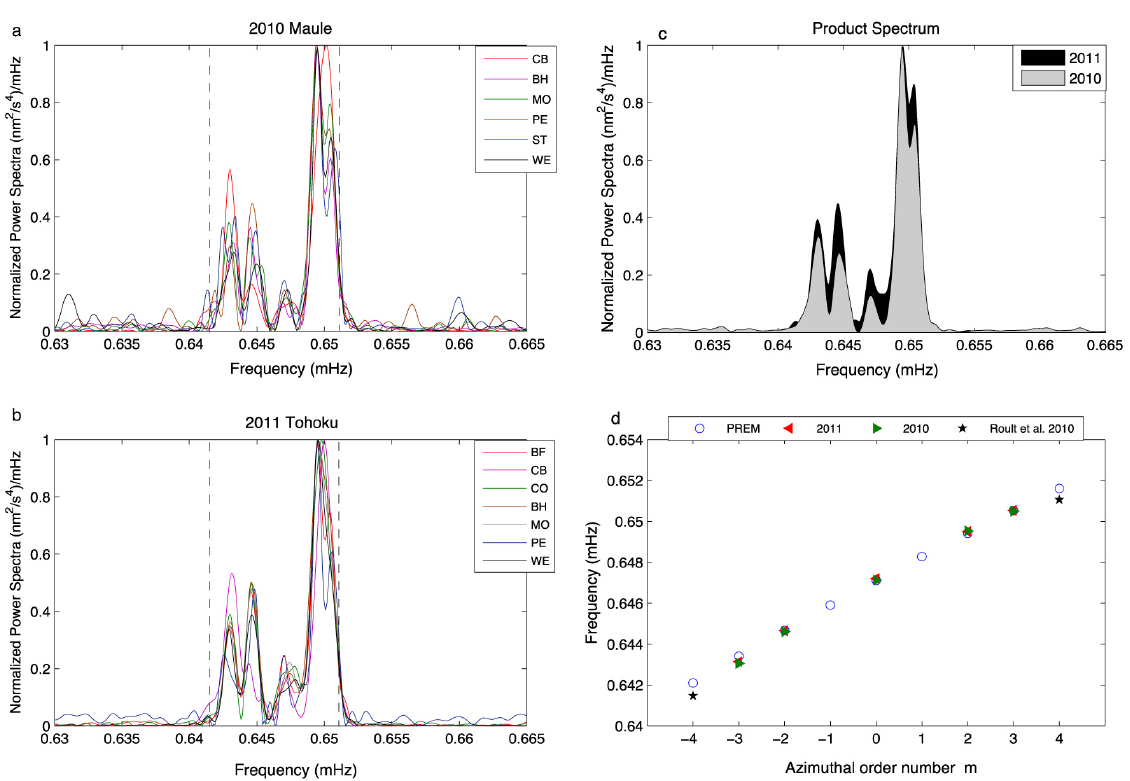
S . (a) The results after the 2010 Maule event; (b) the results after the 2011 Tohoku; (c) the product spectra of the Figure 7. The spectra of 0 4 residual gravity time series after each of the two events; (d) the distributions of the estimated frequencies and the corresponding PREM pre- dictions. The dashed vertical lines indicate the observed frequencies of the singlets m =±4 observed by Roult et al. [2010]. f (mHz) Q f (mHz) Q